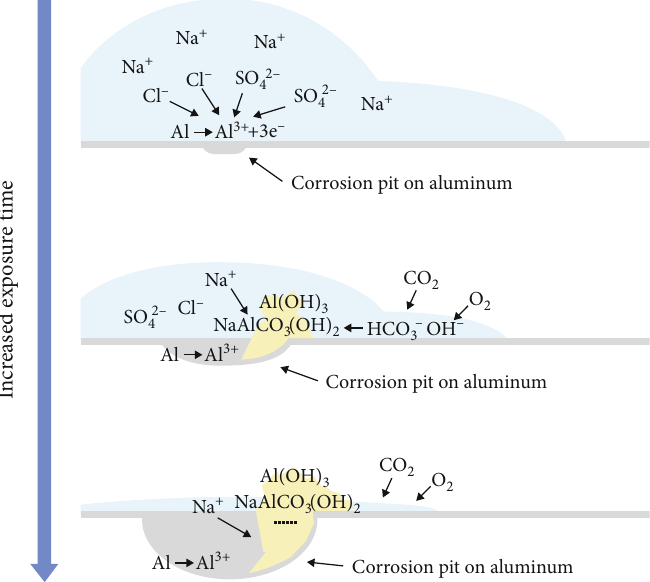
Figure 1: Evidence of atmospheric corrosion in metallic corrosion